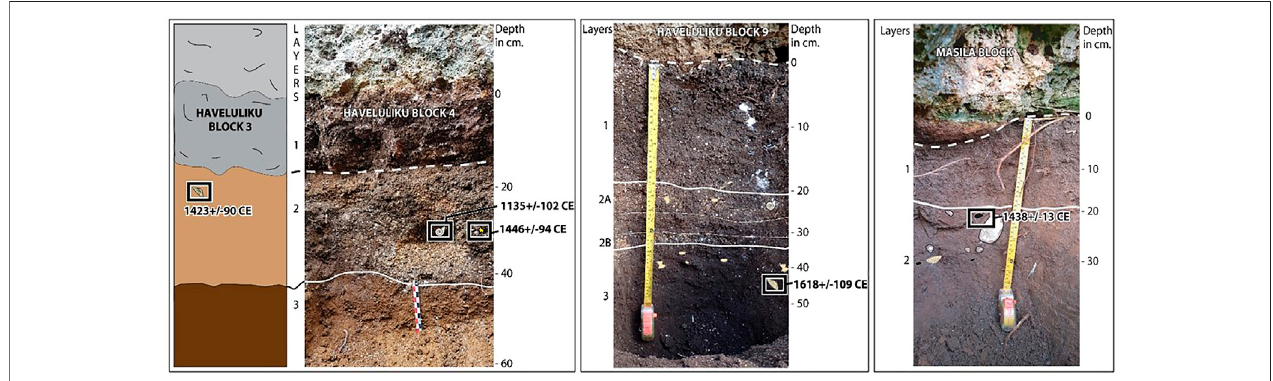
FIGURE 4 | Sediment layers interpreted as tsunami deposits below the boulders at Haveluliku and